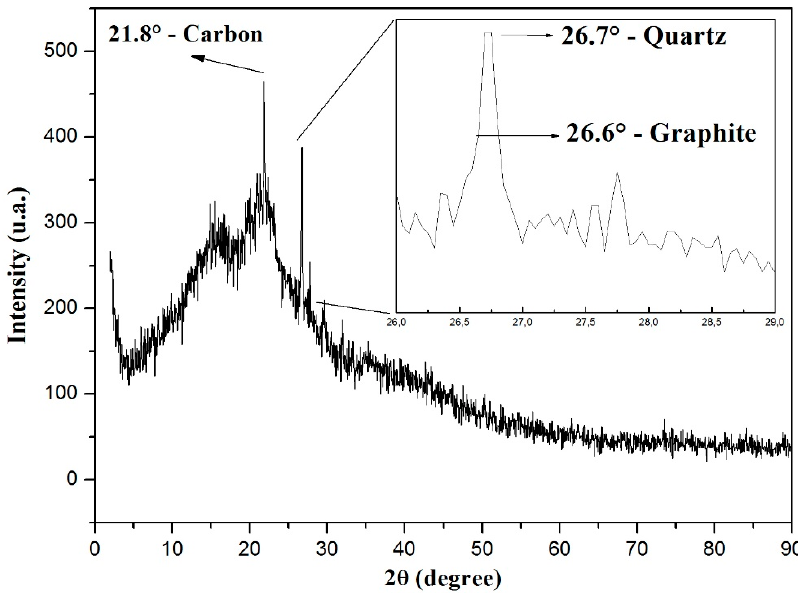
Figure 2. XRD standard shown by the peat sample as amorphous material.